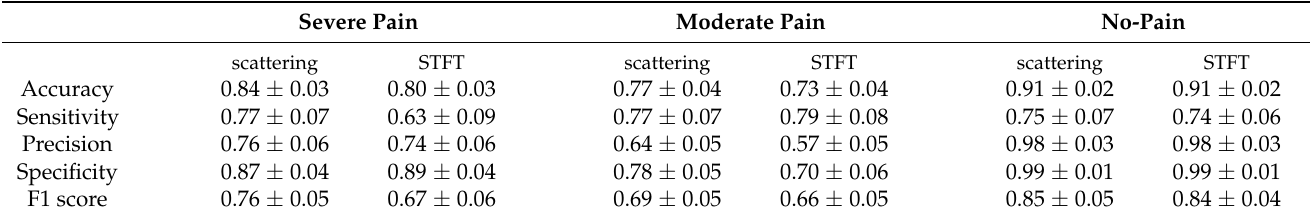
Table 5. Multiclass evaluation results of 10-fold cross-validation (AdaBoost): comparison of short-time Fourier transform (STFT) features and wavelet scattering features